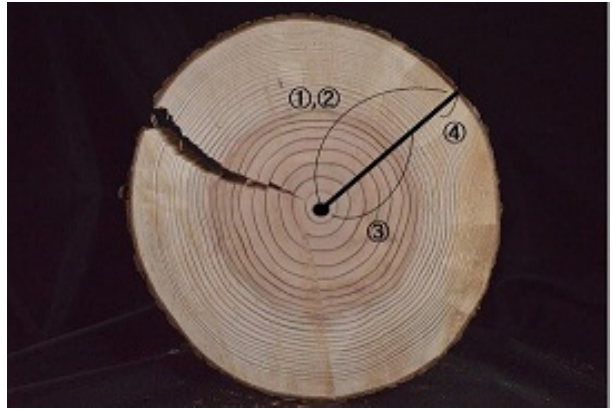
Figure 4. Annual rings